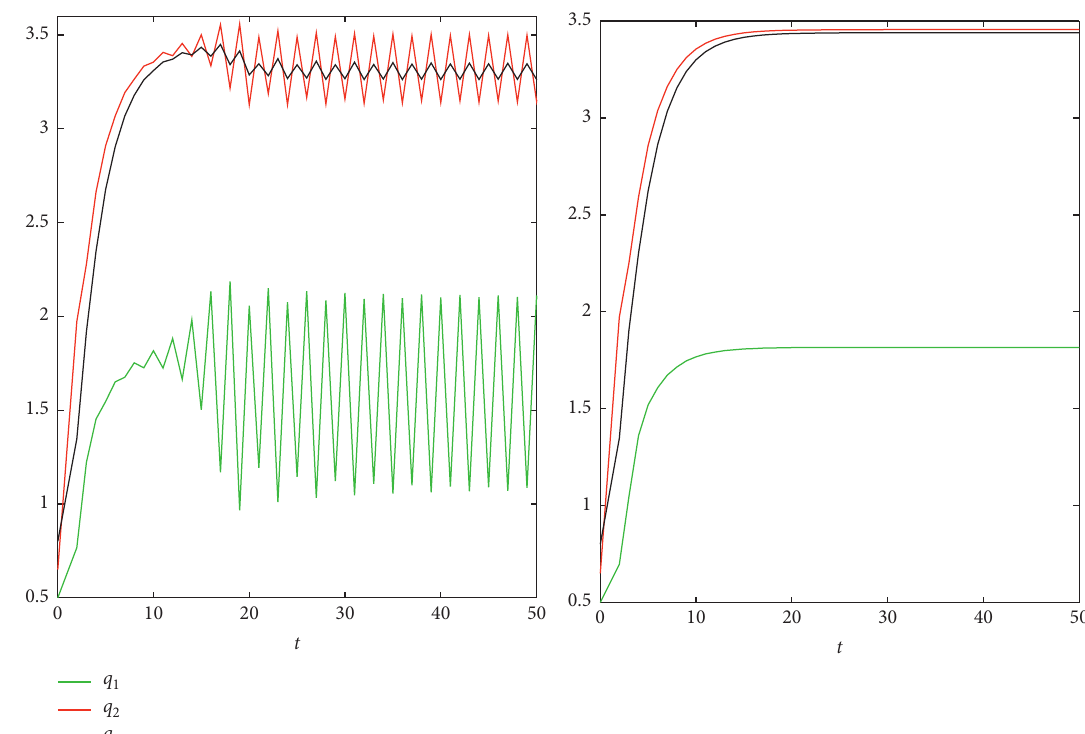
Figure 10: The evolution trajectory of control parameters k � 0 . 1 and k � 0 . 5 the dynamical system (29) with